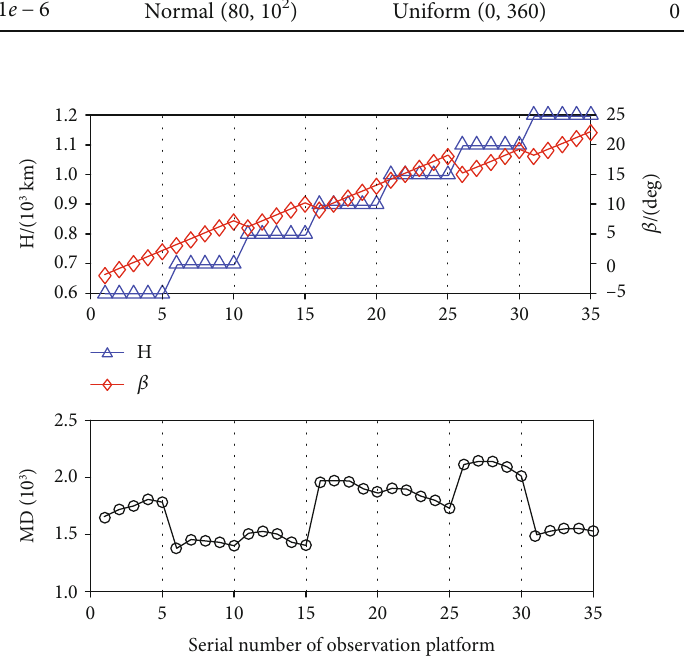
Figure 10: The matching degrees of single platforms with di ff erent H and β